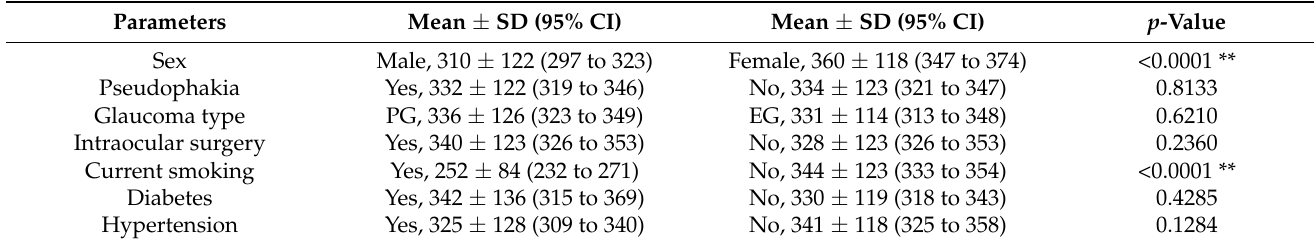
Table 3. Possible association among SCs and various categorical parameters.